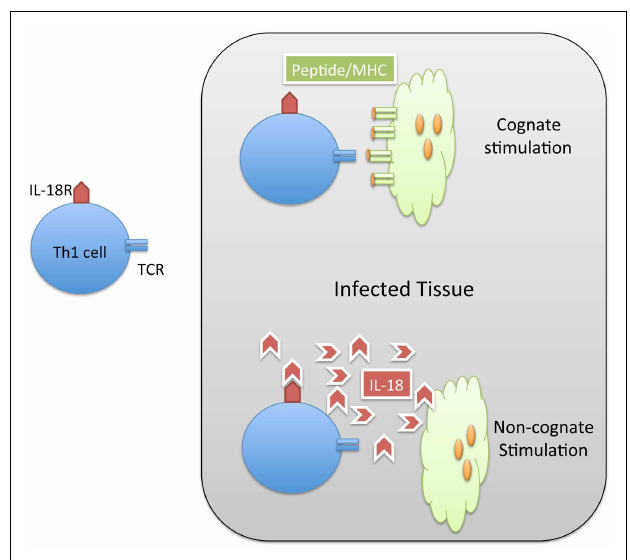
FIGURE 1 |Th1 cells can be activated by cognate and non-cognate stimuli in infected tissue . Naïve CD4T cells are activated in lymphoid tissues to generateTh1 cells specific for Salmonella .These Salmonella -specificT cells can enter infected tissue and be stimulated by cognate (MHC/peptide) stimuli (TOP) or non-cognate (IL-18) stimuli. In both cases, the result of this stimulation is the production of IFN-gamma and resolution of the